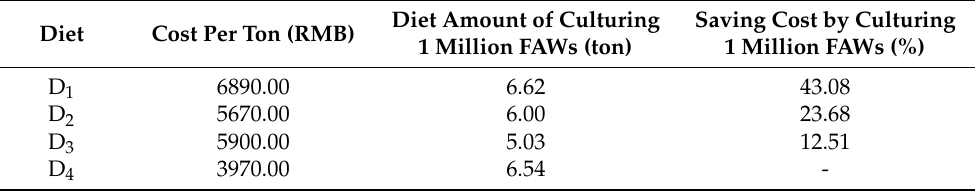
Table 6. Cost per ton of diet material, diet amounts of culturing 1 million FAWs and the cost saving of D 2 compared with other